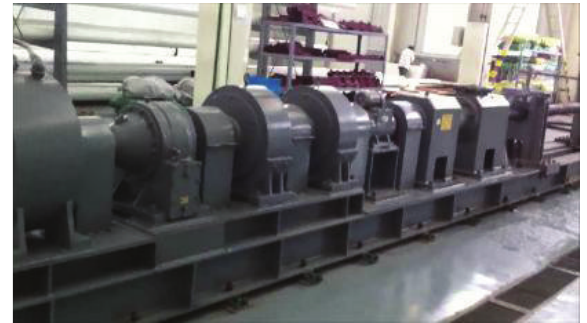
Figure 13: Laboratory test and its equipment.